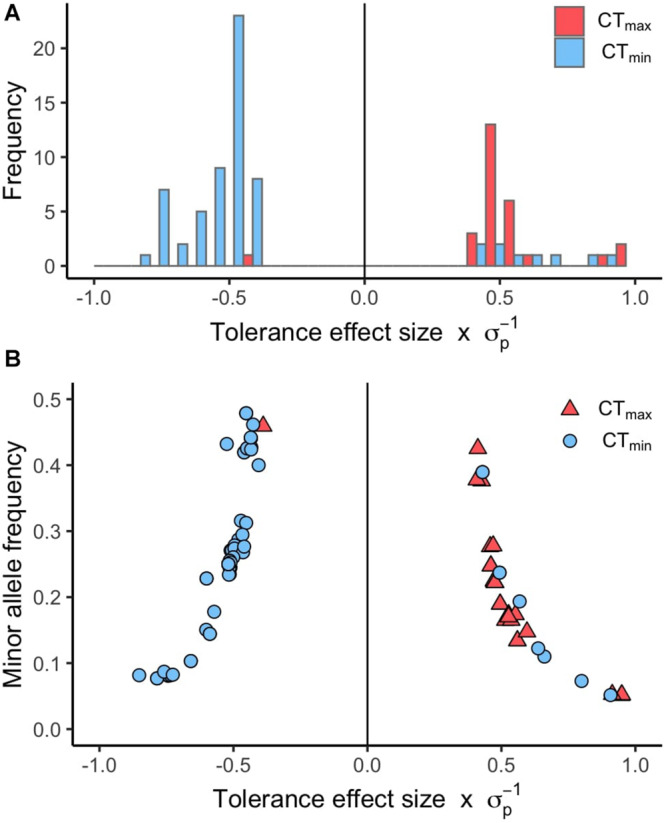
Distribution of effect sizes for SNPs associated with CTmin and CTmax. (A) Histogram of the tolerance effect size scaled by the phenotypic standard deviation (σp) for the same allelic variants. (B) Scatter plot of the minor allele frequency versus the tolerance effect size scaled by the phenotypic standard deviation (σp) for the allelic variants associated with CTmin and CTmax (p-value < 1E-5).